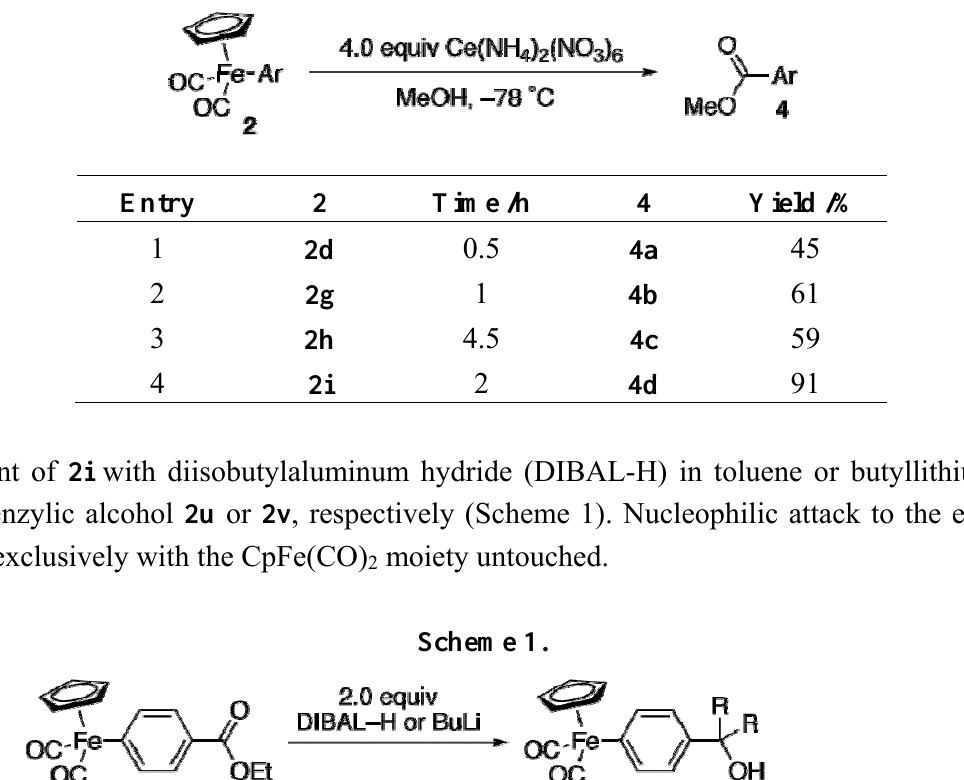
Table 5. Oxidative Methoxycarbonylation of Functionalized Aryliron Complexes.